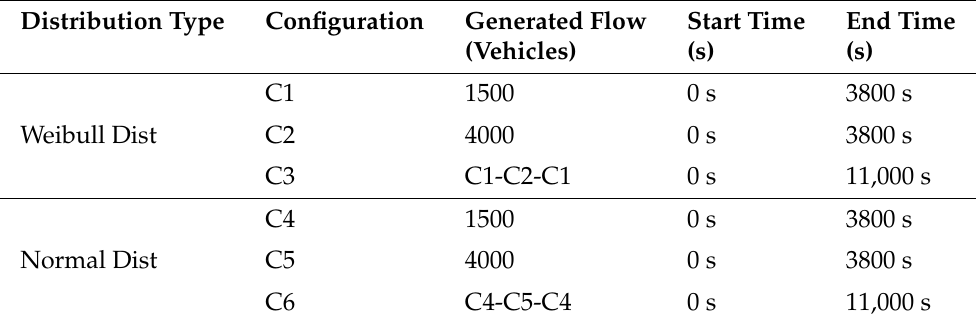
Table 1. Simulated traffic